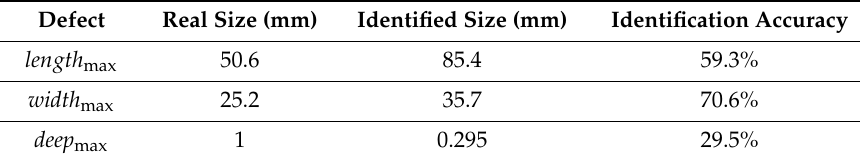
Table 3. Quantitative identification results of the defect.